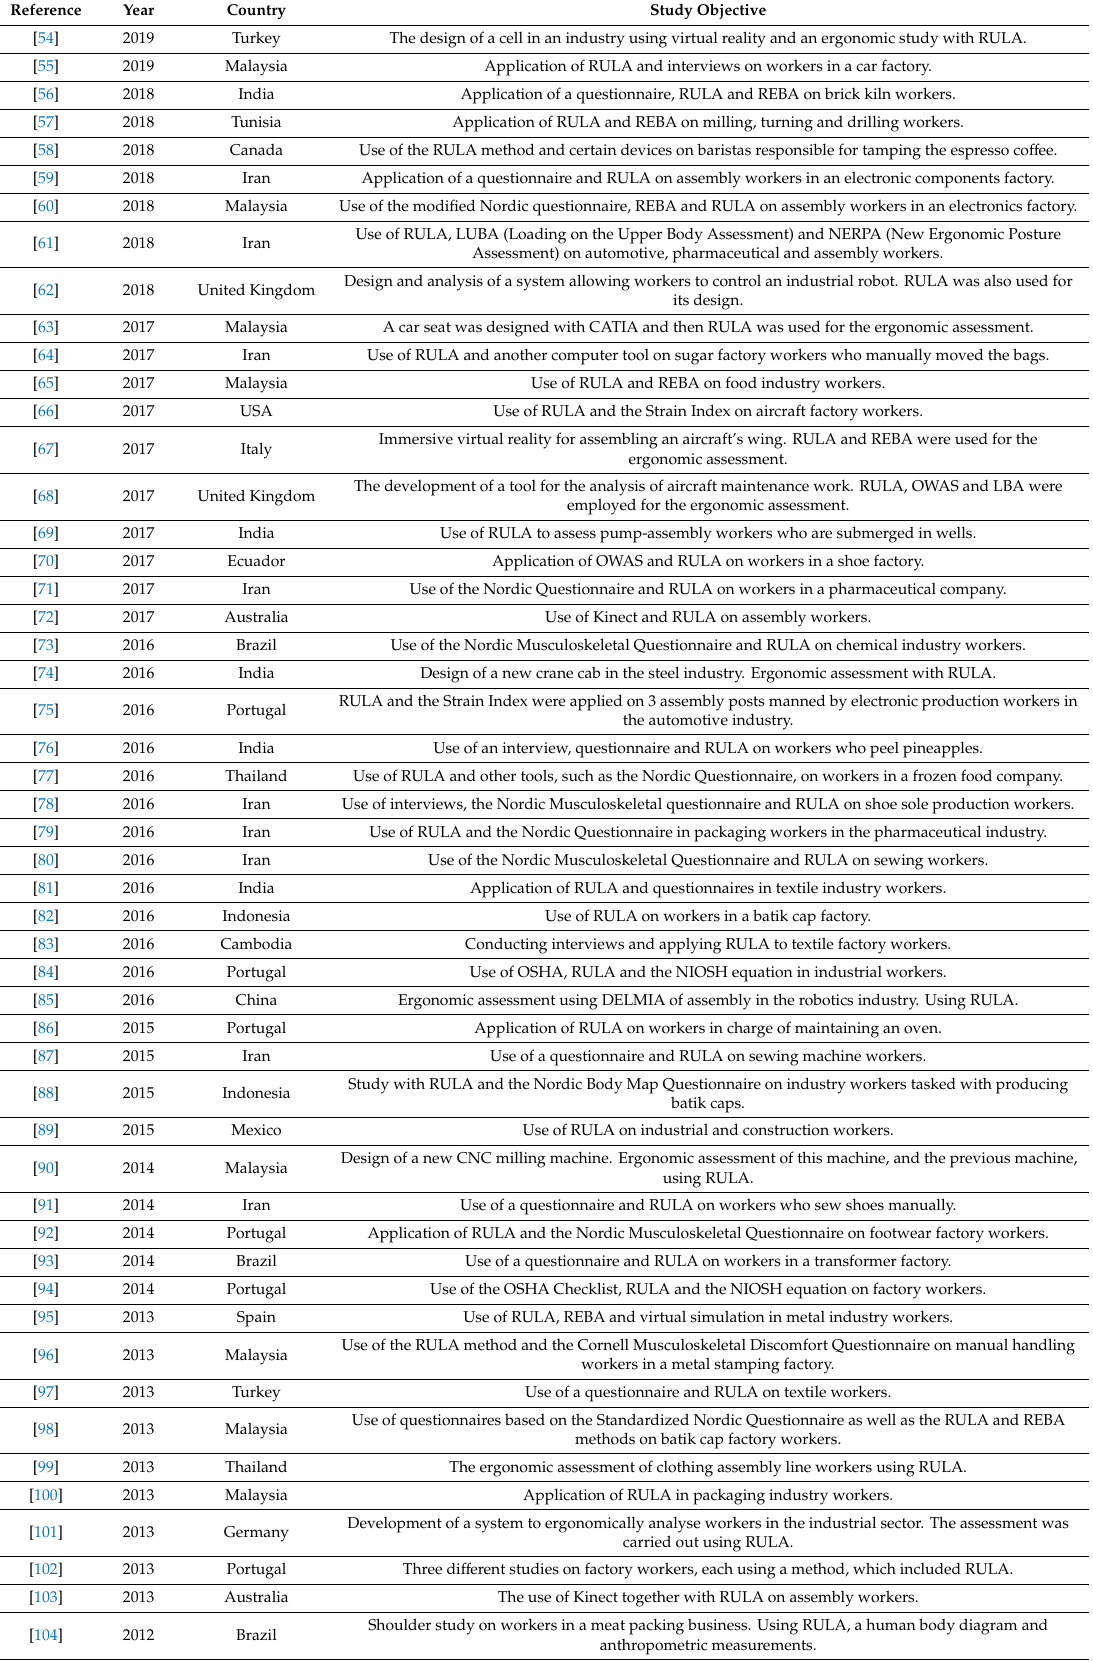
Table 5. Manufacturing.